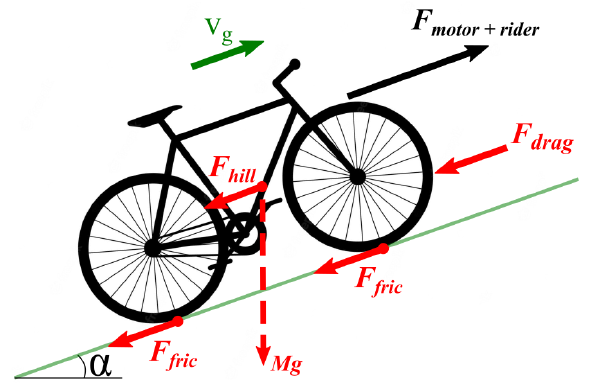
Figure 4. Forces in a bicycle moving